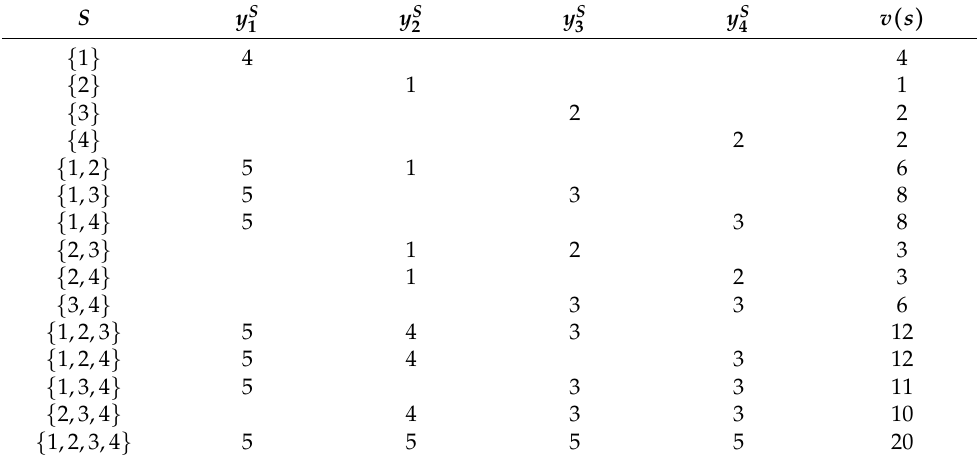
Table 3. PMAS profit game ( N , v , (cid:23) ) for Example